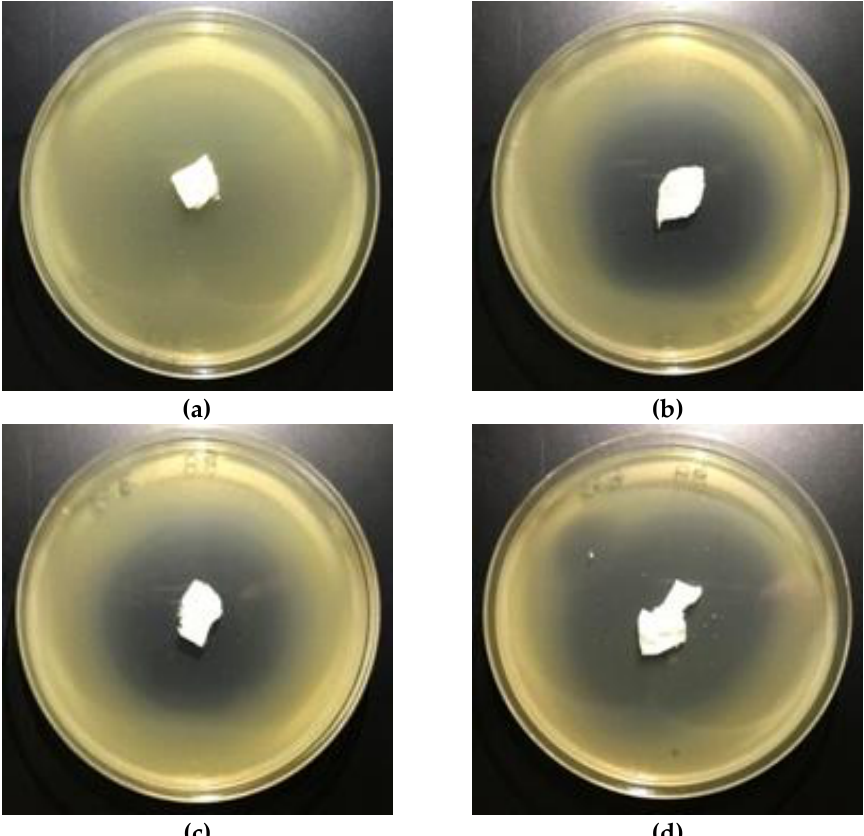
Figure 9. The nonwovens antimicrobial activity tests against S. aureus. Inhibition zones of bacterial growth on Petri dishes, modified PLA nonwoven with fosfomycin coating pastes concentrations: a —0%, b —0.005%; c —0.01%; d - 0,1%.